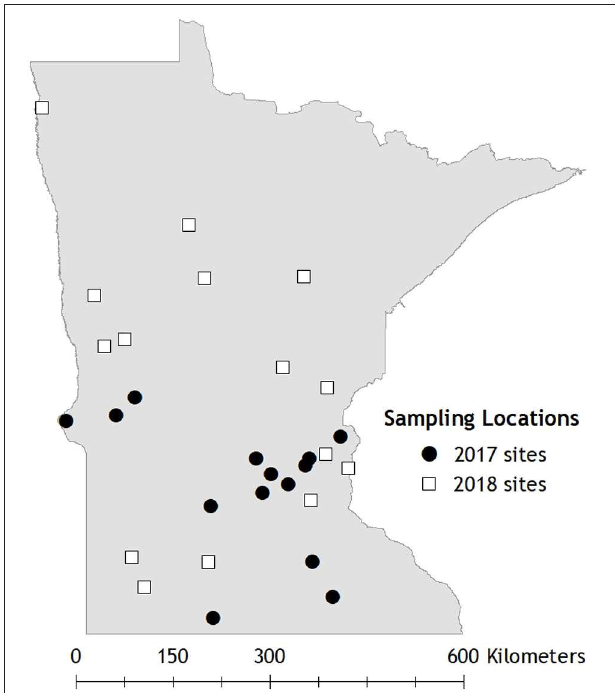
FIGURE 3 | 29 field sampling locations in Minnesota where Rapid Assessments and Integrated Monarch Monitoring Program protocols were